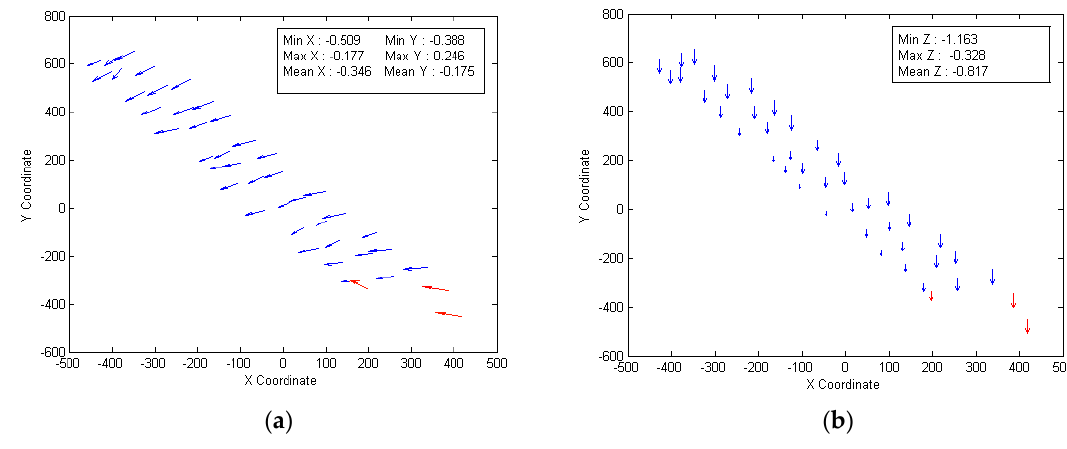
Figure 13. Spatial distribution of orientation residual without GCP: ( a ) horizontal residual distribution; and ( b ) vertical residual distribution. Table 8. Comparison of orientation residual of three experiments.